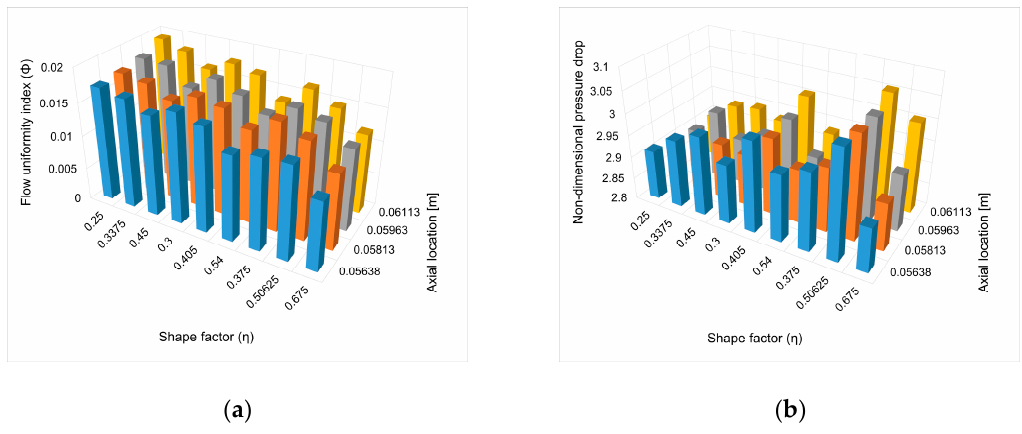
Figure 11. Correlation among parameters in novel U-type manifold design: ( a ) Flow uniformity index vs. shape factors and axial installation locations; ( b ) non-dimensional pressure drop vs. shape factors and axial installation locations.